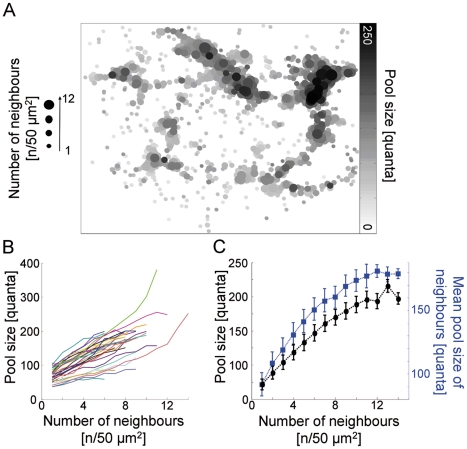
Relation of recycling pool size and number of neighbours.
A, Analytical image calculated from a representative FM 1–43 turnover experiment. Each detected synapse is marked by a filled circle, which is gray-shaded according to its recycling pool size and size-coded for its number of neighbours in a 50 µm2 environment. (For the original difference image of images before and after electrical stimulation see Figure S2). B, Relation of recycling pool sizes and neighbour numbers in 30 independent FM 1–43 turnover experiments. Each experiment is represented by an individually coloured line. There was a strong correlation between pool size and number of neighbours that was conserved in all individual experiments (N = 30; mean Spearman's ρ = 0.97±0.03, p<0.01). C, Summary graph of B. Black circles: Relation between number of neighbours and vesicle pool sizes (Cohens d = 4.76; Spearman's ρ = 0.97, p<0.001). Blue squares: Relation between the number of neighbours and the mean pool size of their neighbouring synapses (Cohens d = 2.30; Spearman's ρ = 0.95, p<0.001). Error bars indicate standard error of the mean (N = 30, n = 22528).